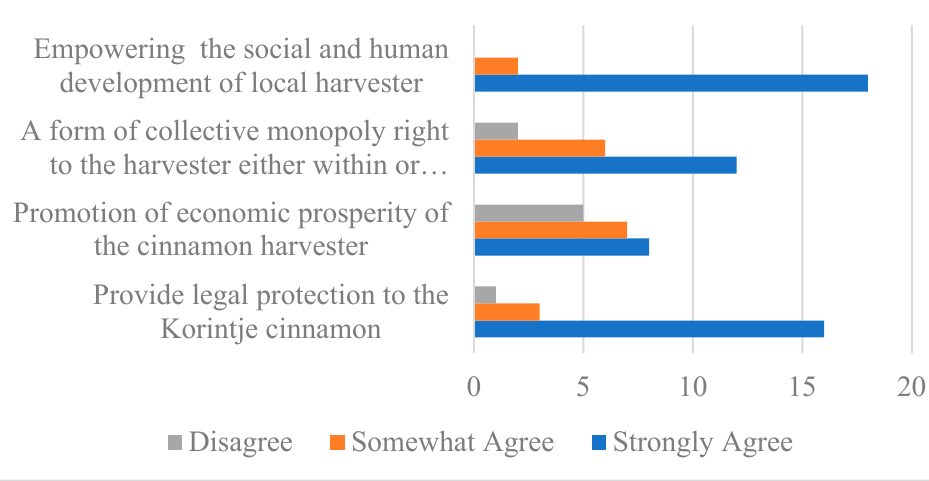
Figure 11. The function of GI for TAKTIK members.